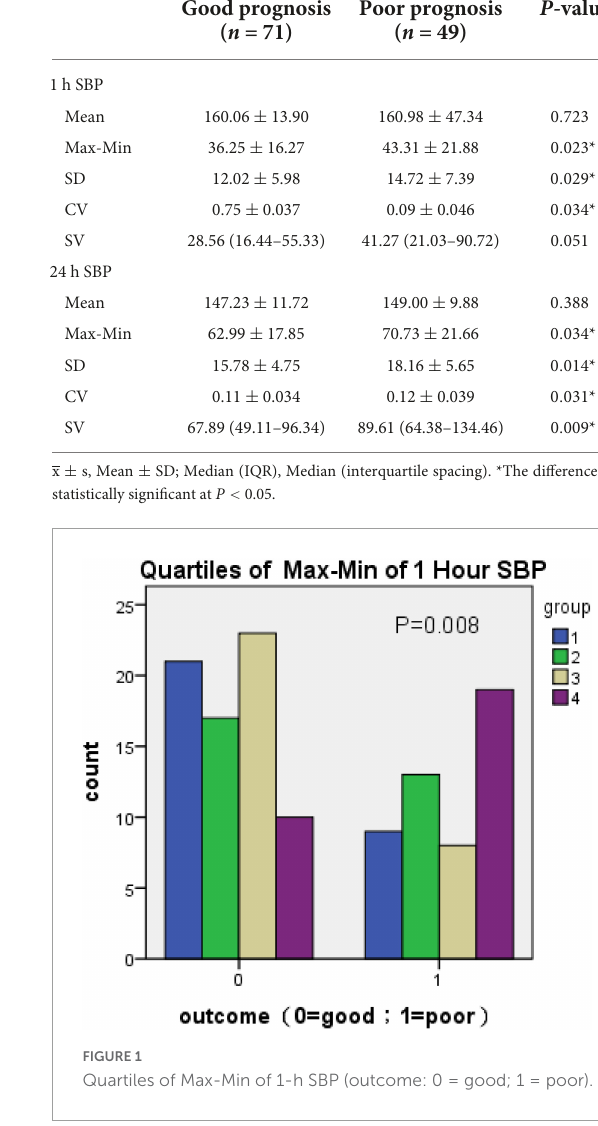
perfusion parameters cerebral blood flow (CBF) and cerebral blood volume (CBV) were